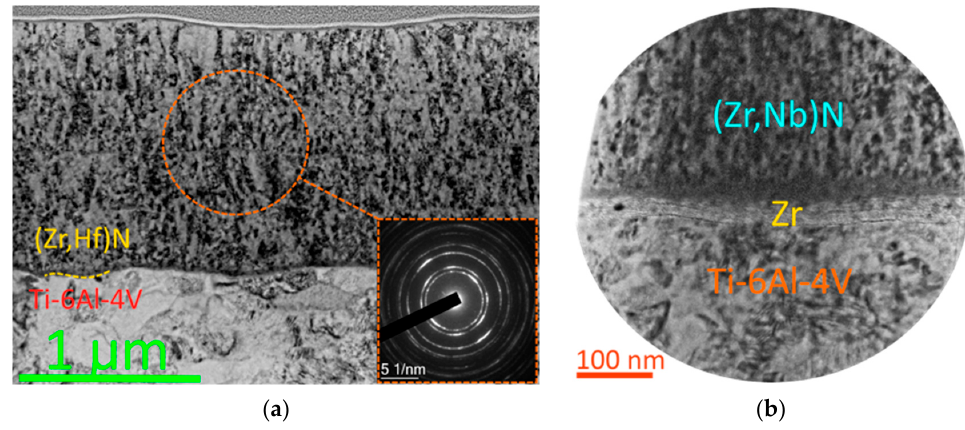
Figure 7. Structure of the ( a ) (Zr,Hf)N coating; ( b ) Zr-(Zr,Nb)N coating with Zr adhesive sublayer deposited on a Ti–6Al–4V substrate (TEM).